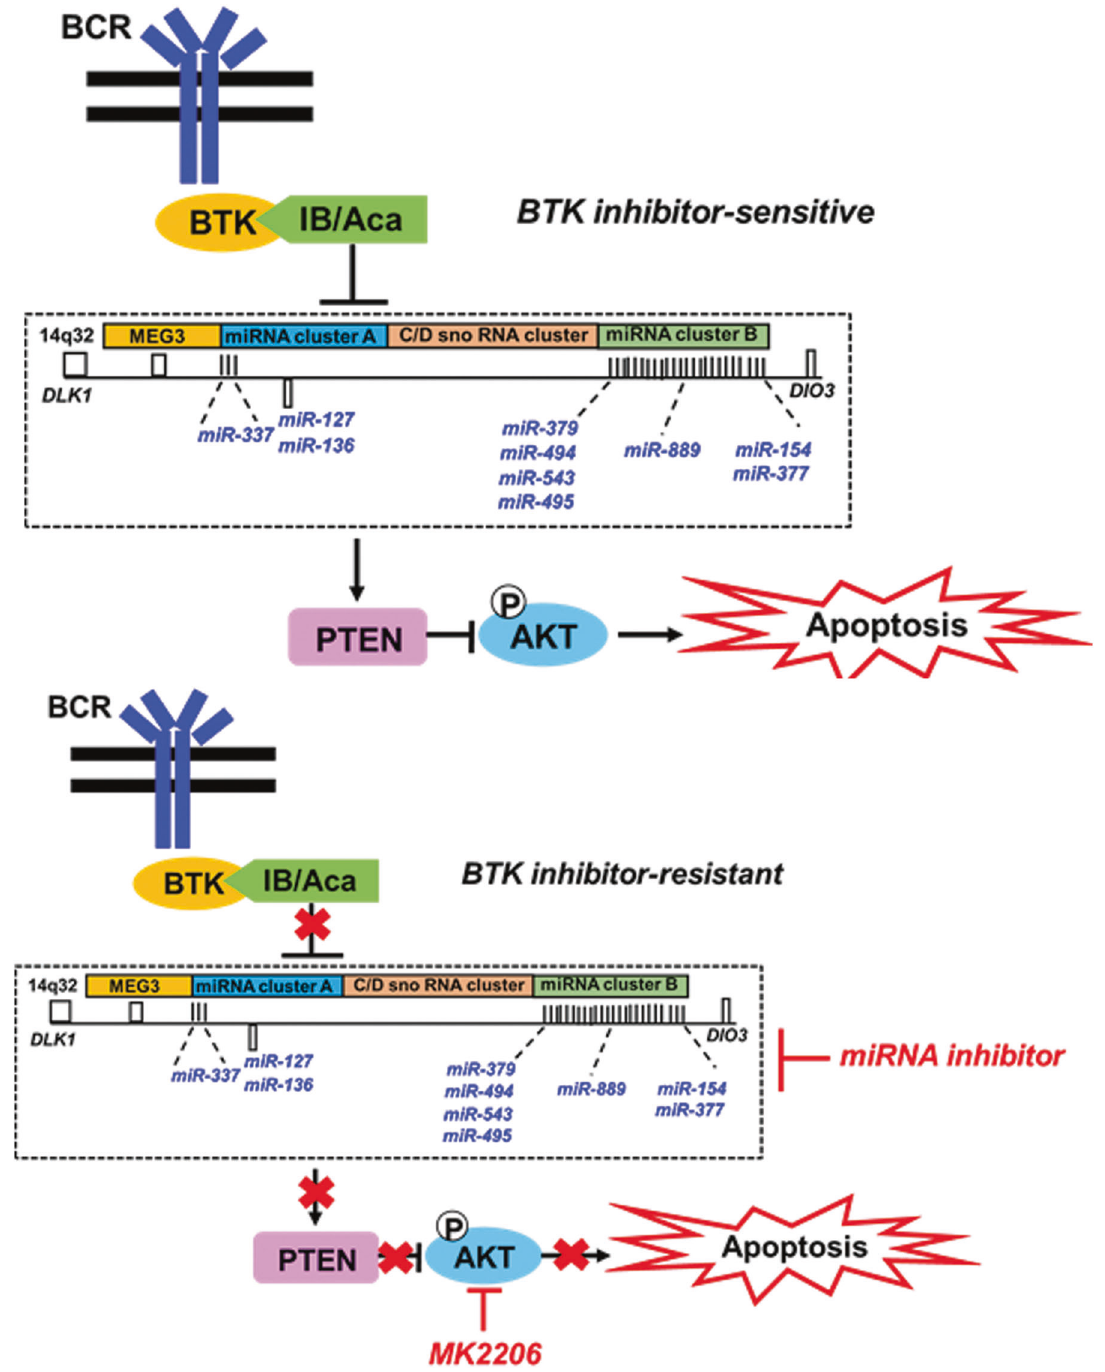
Fig. 7 Schematic representation of 14q32 cluster miRNAs-dependent resistance to BTK inhibition in B-cell lymphoid malignancies. BTK inhibitor (ibrutinib or acalabrutinib) downregulates miRNAs in the 14q32 cluster region, such as miR-494, miR-495, miR-543, resulting in increased PTEN expression and induction of apoptosis via antagonizing AKT in BTKi-sensitive cells (upper panel). In BTKi-R cells, overexpressed miRNAs in the 14q32 cluster region downregulate PTEN and promote pro-survival AKT activation resulting in reduced apoptosis. AKT inhibition or cooperative miRNA inhibition rescues apoptosis in BTKi-R cells by restoring PTEN and inhibition of